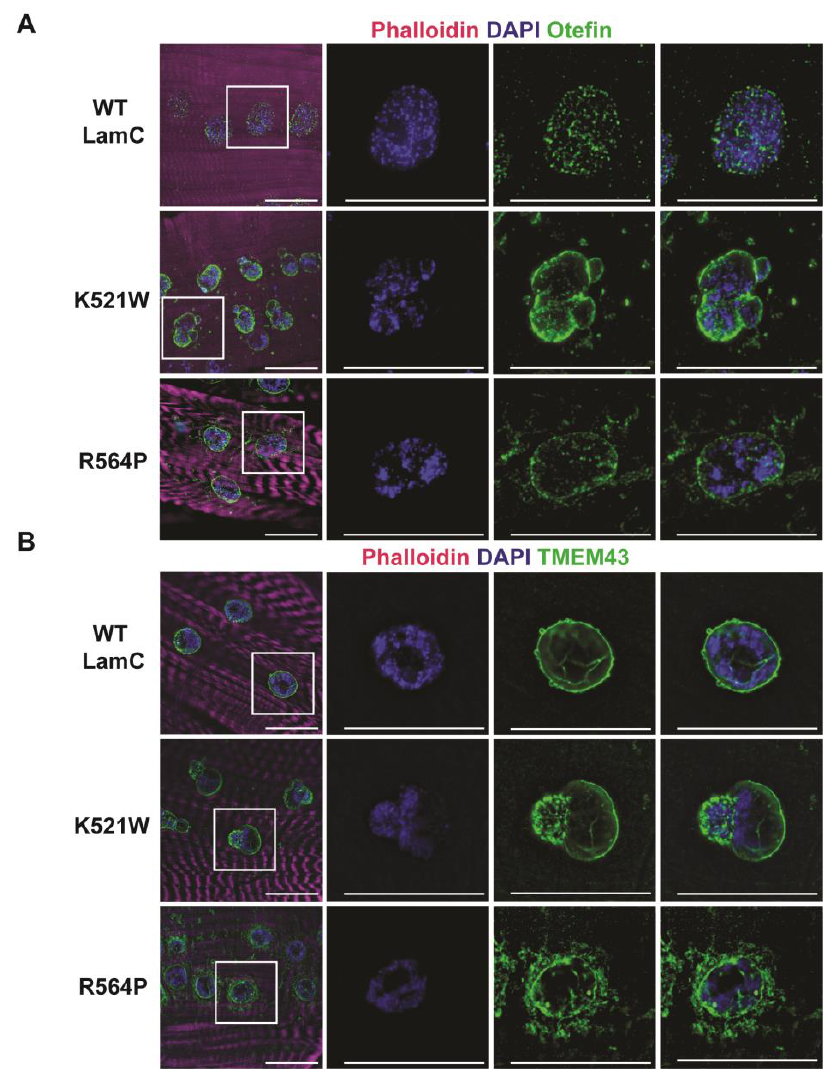
Figure 3. LamC K521W and R564P alter the localization of nuclear envelope proteins TMEM43 and Otefin. ( A ) Larval body wall muscles expressing either wild-type or mutant LamC were stained with phalloidin (magenta), DAPI (blue), and antibodies to Otefin (green). Note the cytoplasmic aggregation caused by both mutants. The white box outlines the magnified region shown on the right. ( B ) Larval body wall muscles expressing either wild-type or mutant LamC were stained with phalloidin (magenta), DAPI (blue), and antibodies to TMEM43 (green). Note the clustering of TMEM43 foci caused by LamC K521W and the cytoplasmic aggregation caused by LamC R564P. The scale bar represents 30 µm.